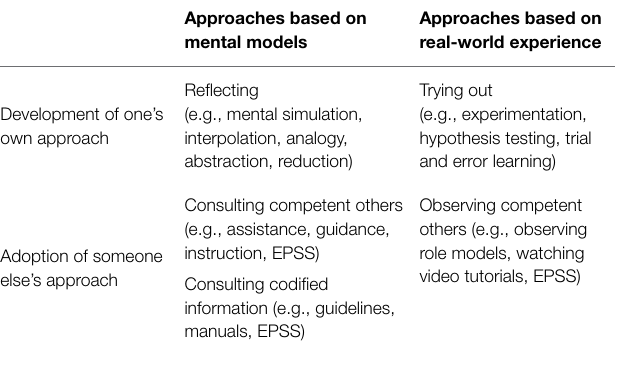
TABLE 1 | Approaches to problem solving in the workplace (Rausch, 2011, p. 98; Rausch et al., 2015, p. 452). Approaches based on mental